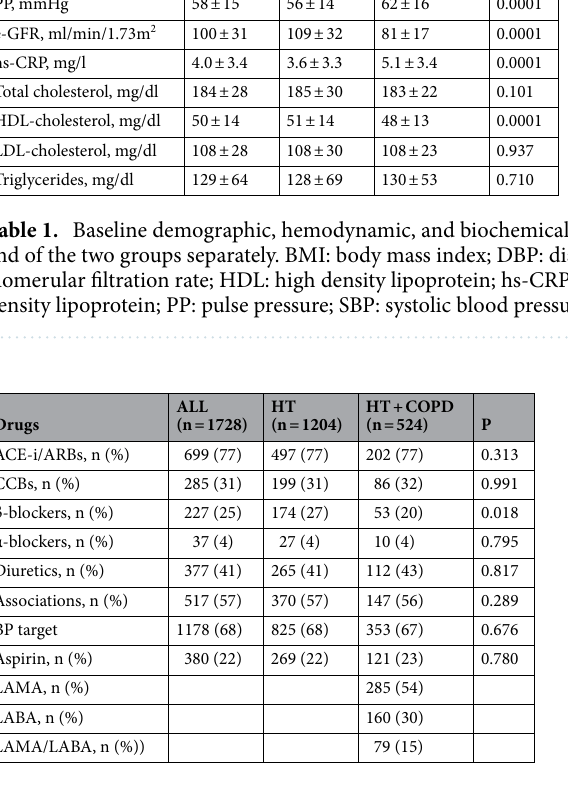
Table 2. Baseline pharmacological treatment in the whole study population and in the two groups separately. ACE-i: angiotensin converting enzyme inhibitors; ARBs: angiotensin receptor inhibitors; BP: blood pressure; CCBs: calcium channel blockers; LABA: long-acting β 2 -agonists; LAMA: long-acting muscarinic antagonists.